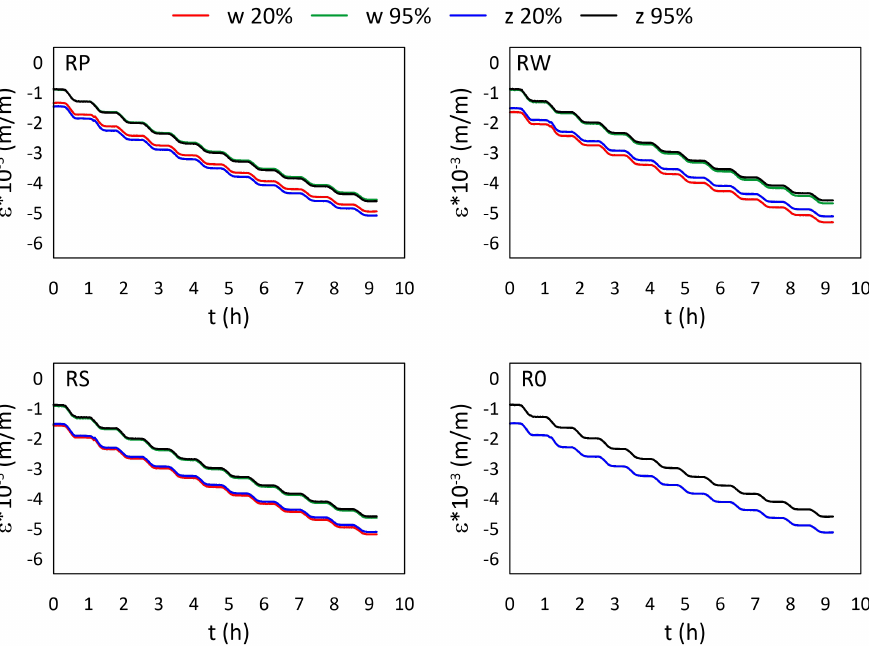
Figure 8. Strain measured by FBG sensors for M3 Crystal samples under sub-zero temperatures; FBG sensors: w —embedded, and z